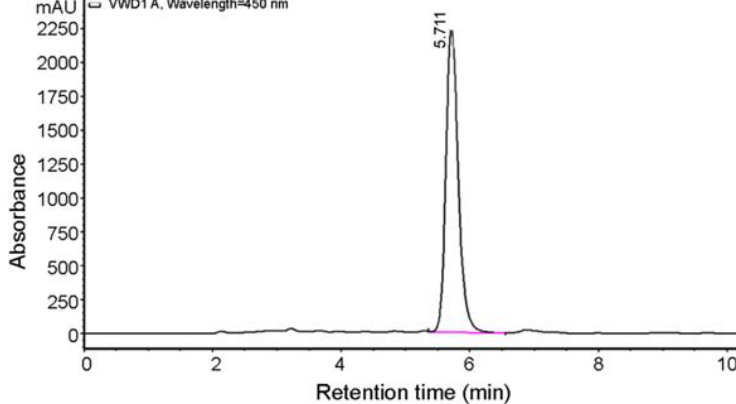
Fig. 1: HPLC chromatogram of a 500 µg/L fucoxanthin standard